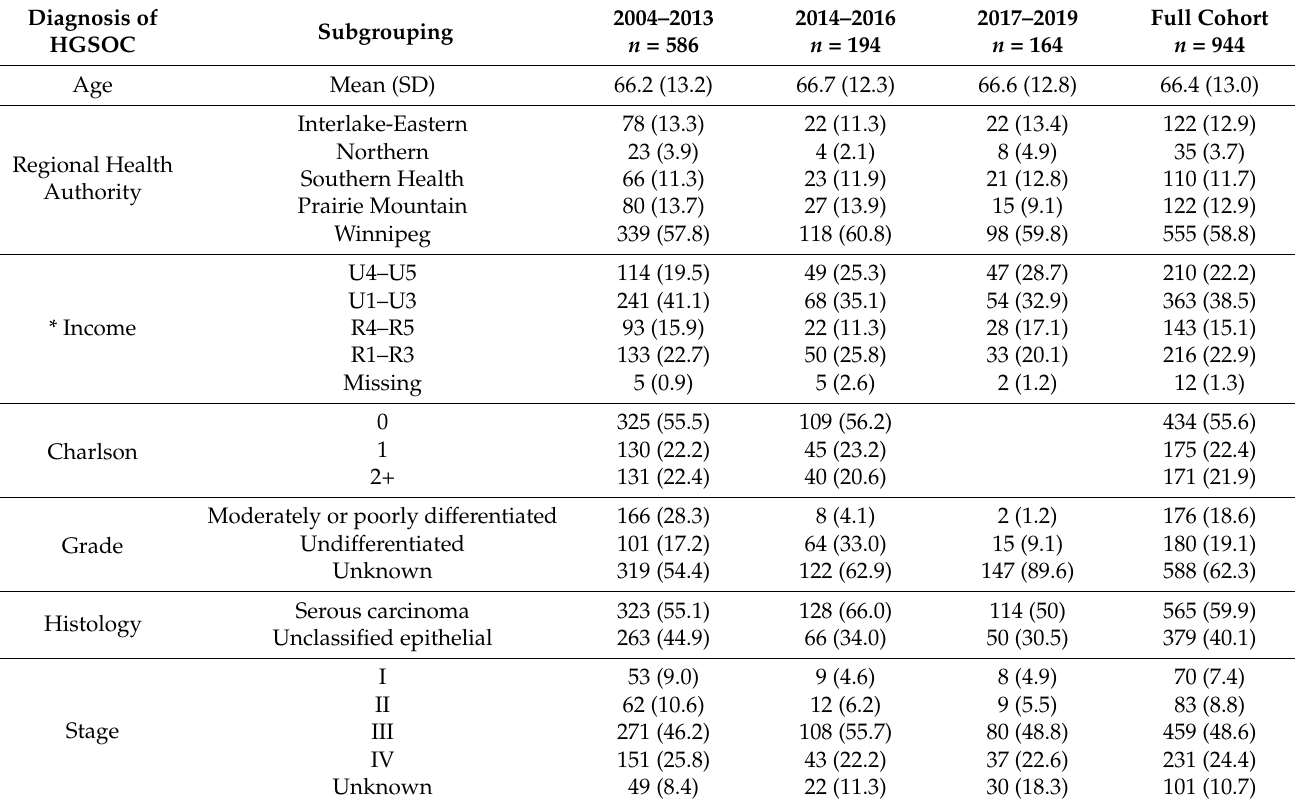
Table 1. Manitoba HGSOC patient and tumour baseline characteristics,